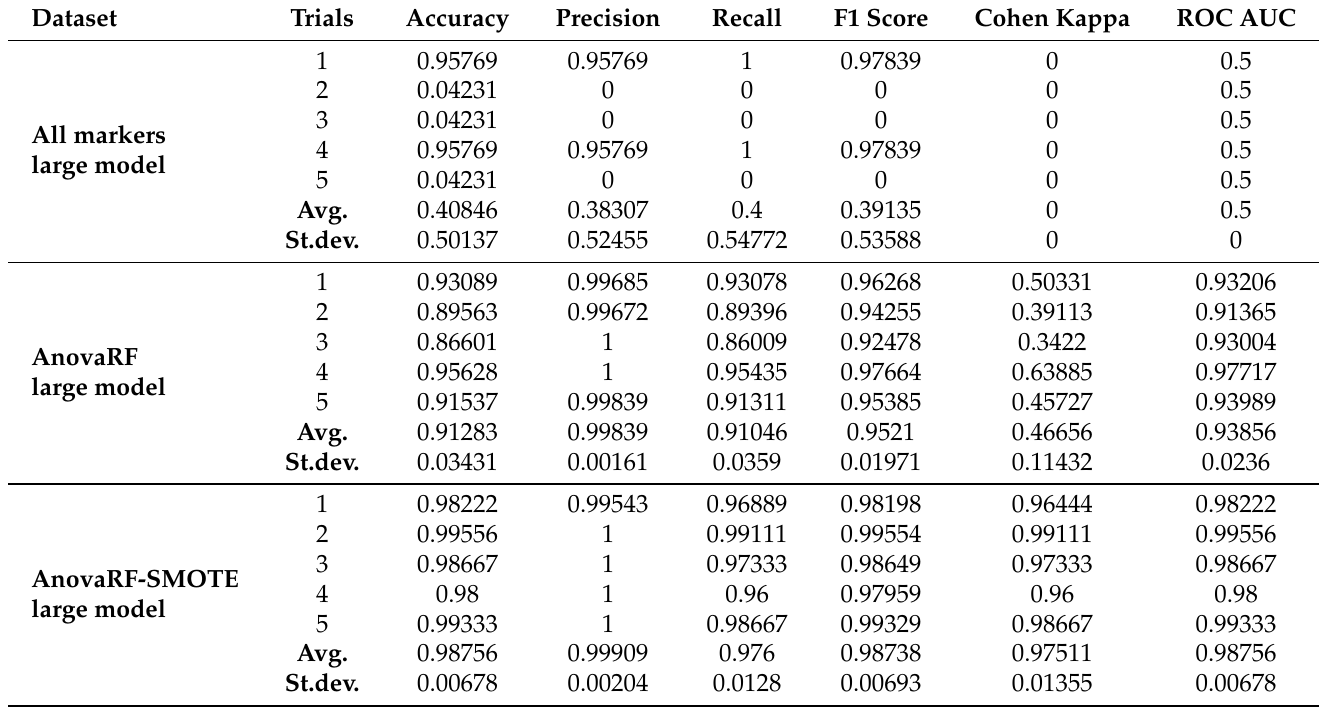
Table A3. Results of deep learning model on 450K dataset using the larger